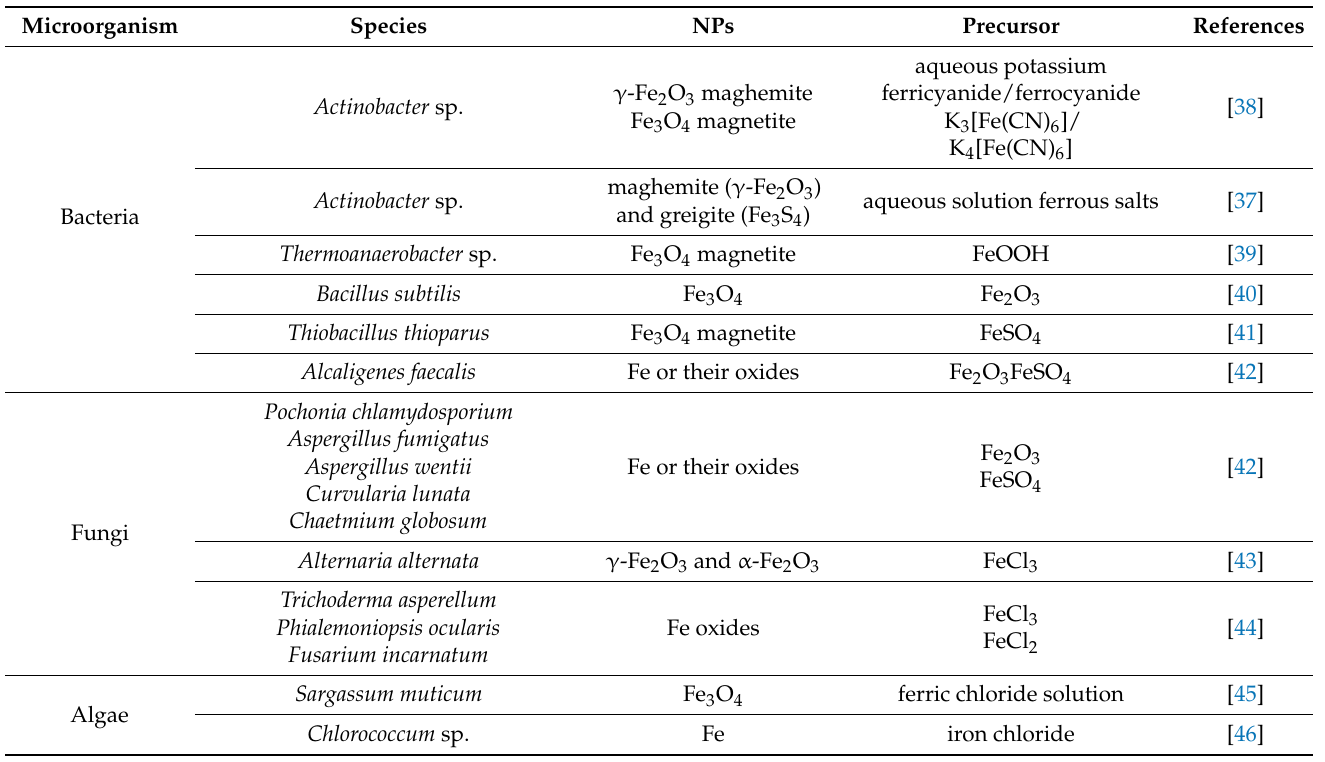
Table 2. Examples of microorganisms used to synthesize iron nanoparticles. Microorganism Species